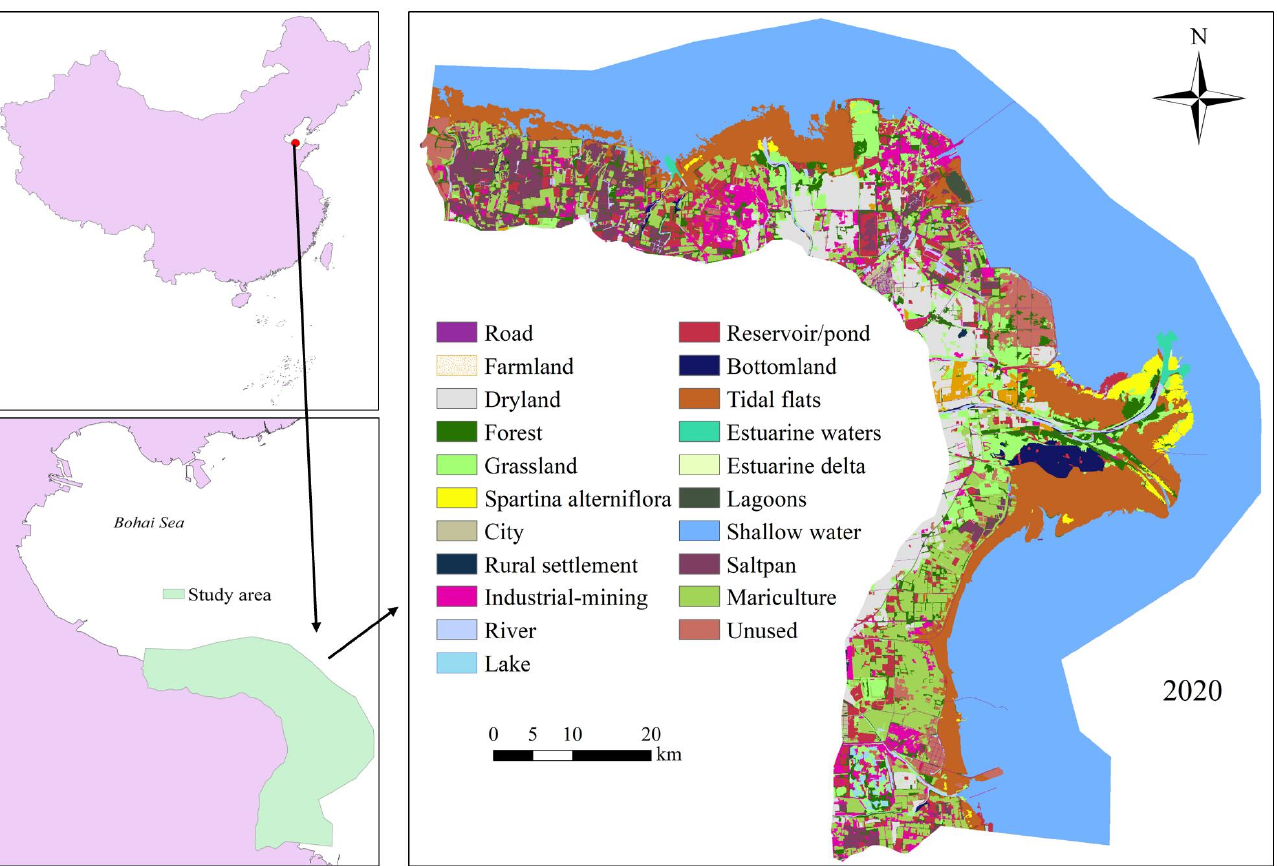
Figure 1. The Yellow River Delta and its land use and land cover in 2020.